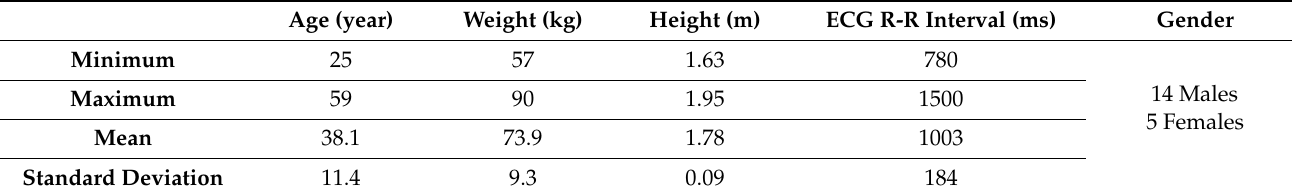
Table 1. Demographic information of the 19 subjects (18 for training and 1 for independent testing). ECG R-R intervals were approximately +/ − 100ms. For 10 of the subjects, volunteers were asked to provide their weights and heights without having them actually